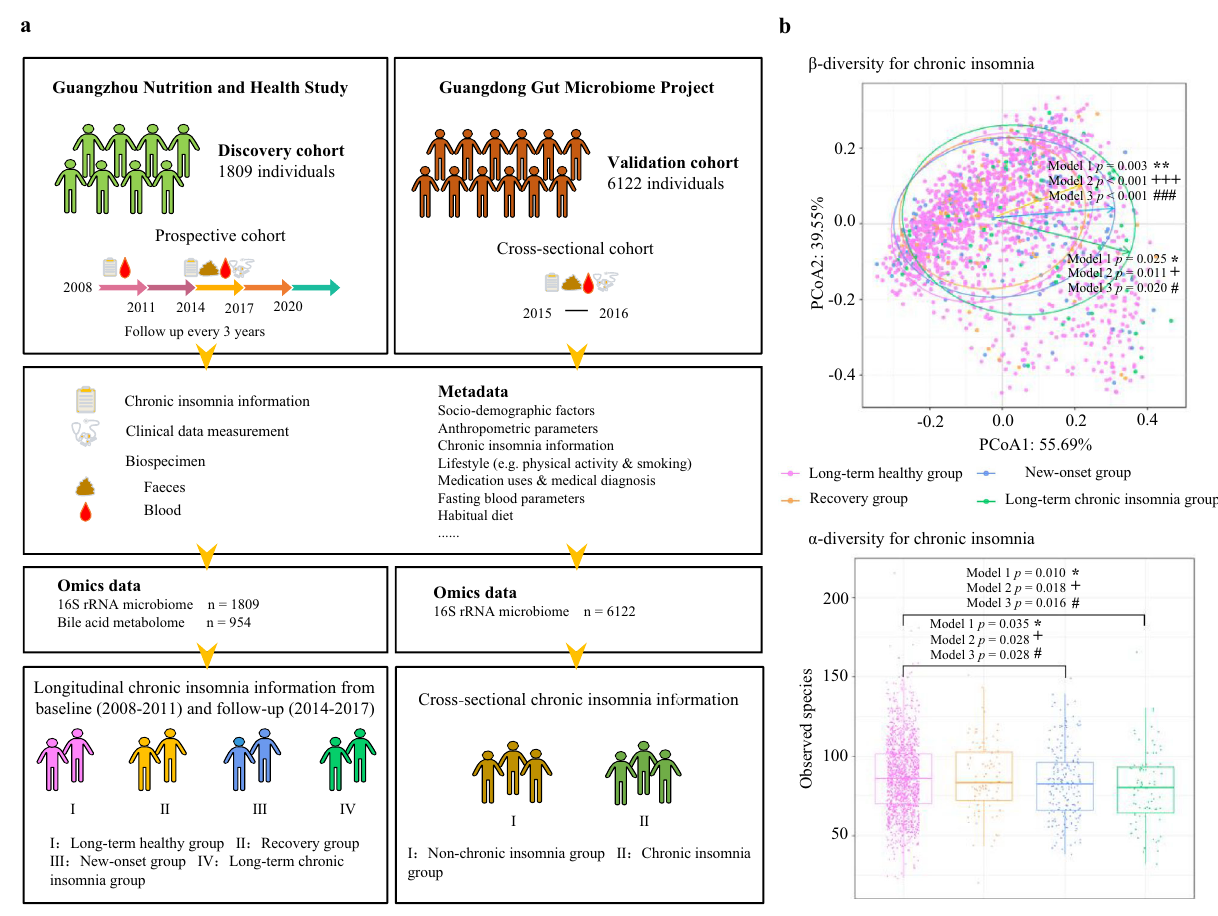
Fig. 1 Study diagram and gut microbiota diversity by chronic insomnia status. a Conceptual diagram of the present study. b The association of chronic insomnia with α -/ β - microbial diversity among the four groups ( n = 1809). The association of chronic insomnia with the overall microbial α -diversity parameter Observed species was evaluated using a multivariable linear regression, adjusted for potential confounding factors (three models in the text). Box plots indicate median and interquartile range (IQR). The upper and lower whiskers indicate 1.5 times the IQR from above the upper quartile and below the lower quartile. The results of Shannon index, Chao 1 index, ACE index and Simpson index are reported in Supplementary Fig. 1. β -diversity was evaluated using principal coordinate analysis (PCoA) plot based on Bray-Cutis distance at the genus level. Permutational ANOVA (PERMANOVA) (999 permutations) was used to identify the variation of β -diversity in the human gut microbiota structure comparing the four groups, adjusted for the same covariates. The Benjamini-Hochberg method was used to adjust p values for multiple testing. Value with symbol is signi fi cantly different (model 1: * p < 0.05, ** p < 0.01, *** p < 0.001; model 2: + p < 0.05, ++ p < 0.01, +++ p < 0.001; model 3: # p < 0.05, ## p < 0.01, ### p < 0.001). All statistical tests were two-sided. Source data are provided as a Source Data fi